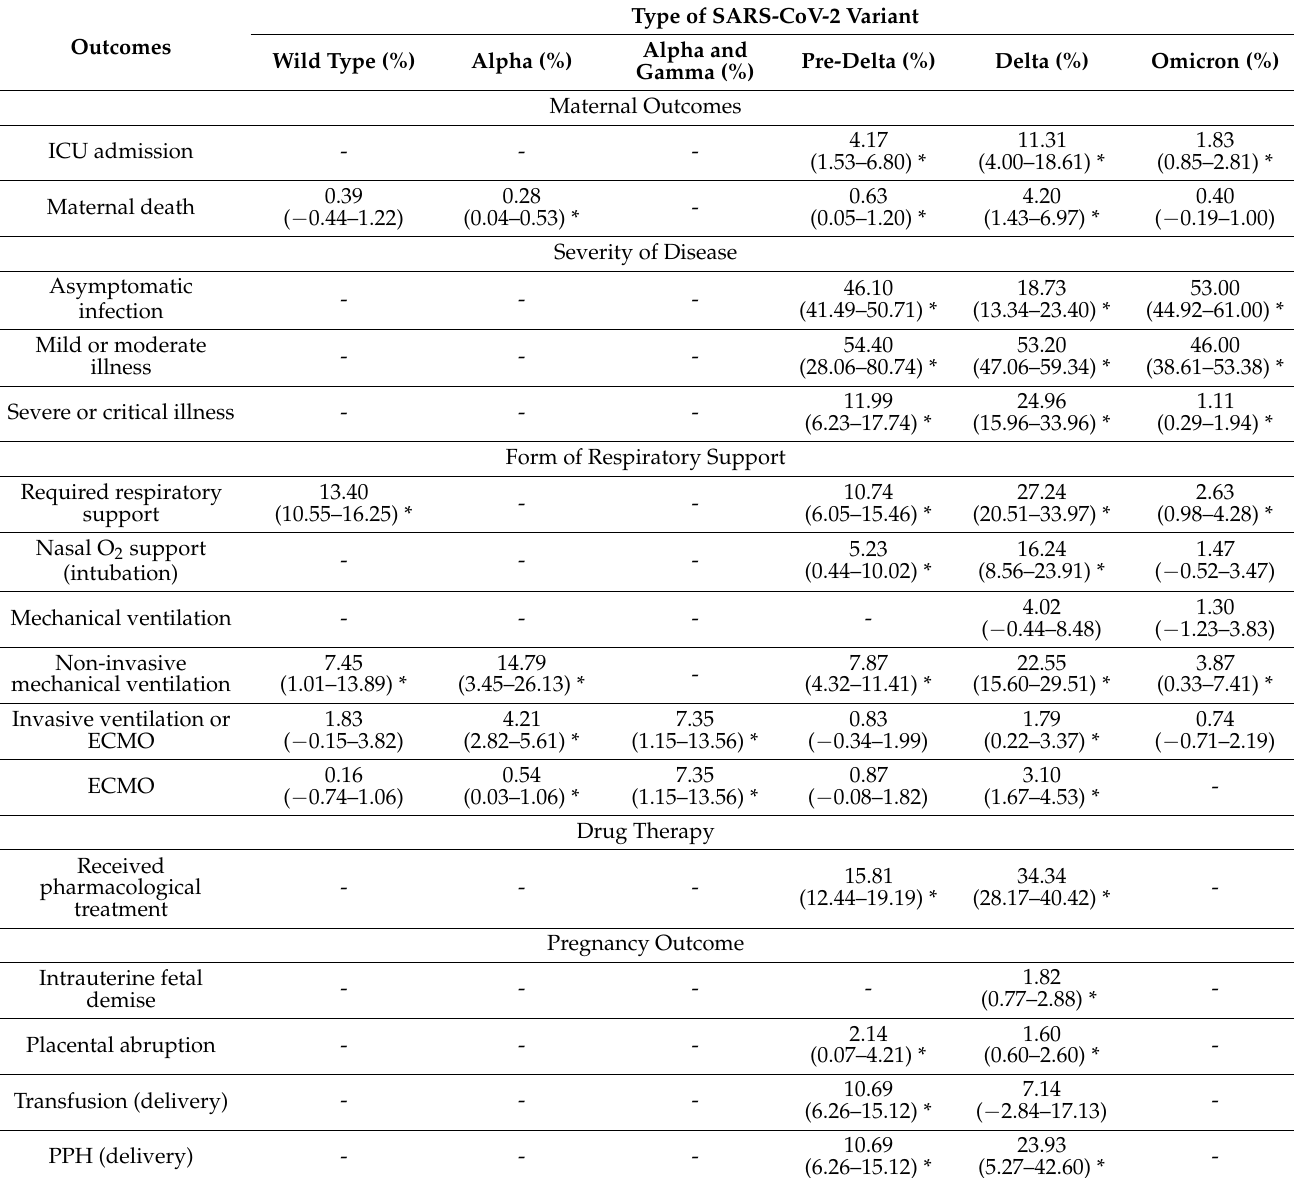
Table 1. Pooled prevalence (PP) of maternal and perinatal outcomes of different SARS-CoV-2 variant infections during